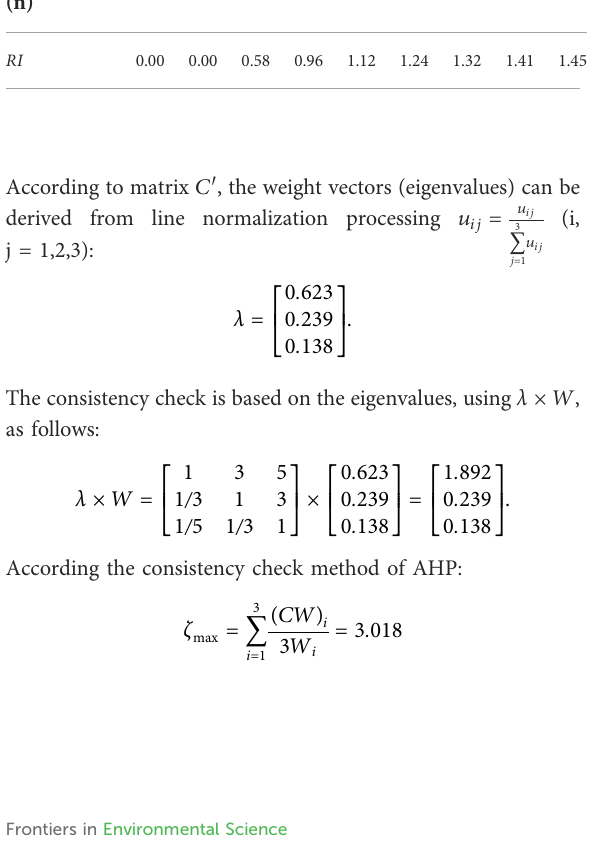
TABLE 6 Freedom index. Matrix